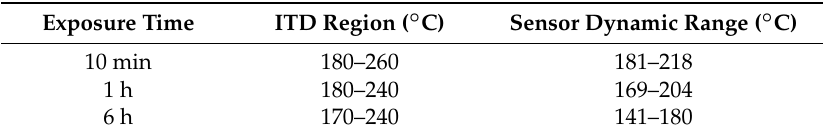
Table 1. Comparison of incipient thermal damage region of CFRE panel and dynamic range of M1-poly (dimethylsiloxane) sensor films.